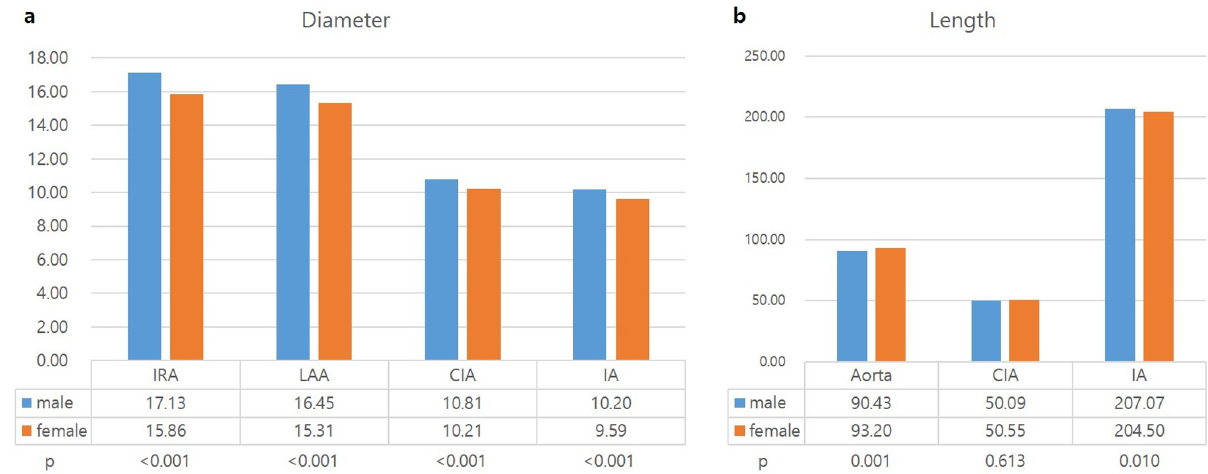
Fig 4. Comparison of aortic diameters between men and women with the same body surface area. IRA, infrarenal aorta; LAA, lower abdominal aorta; CIA, common iliac artery; IA, iliac